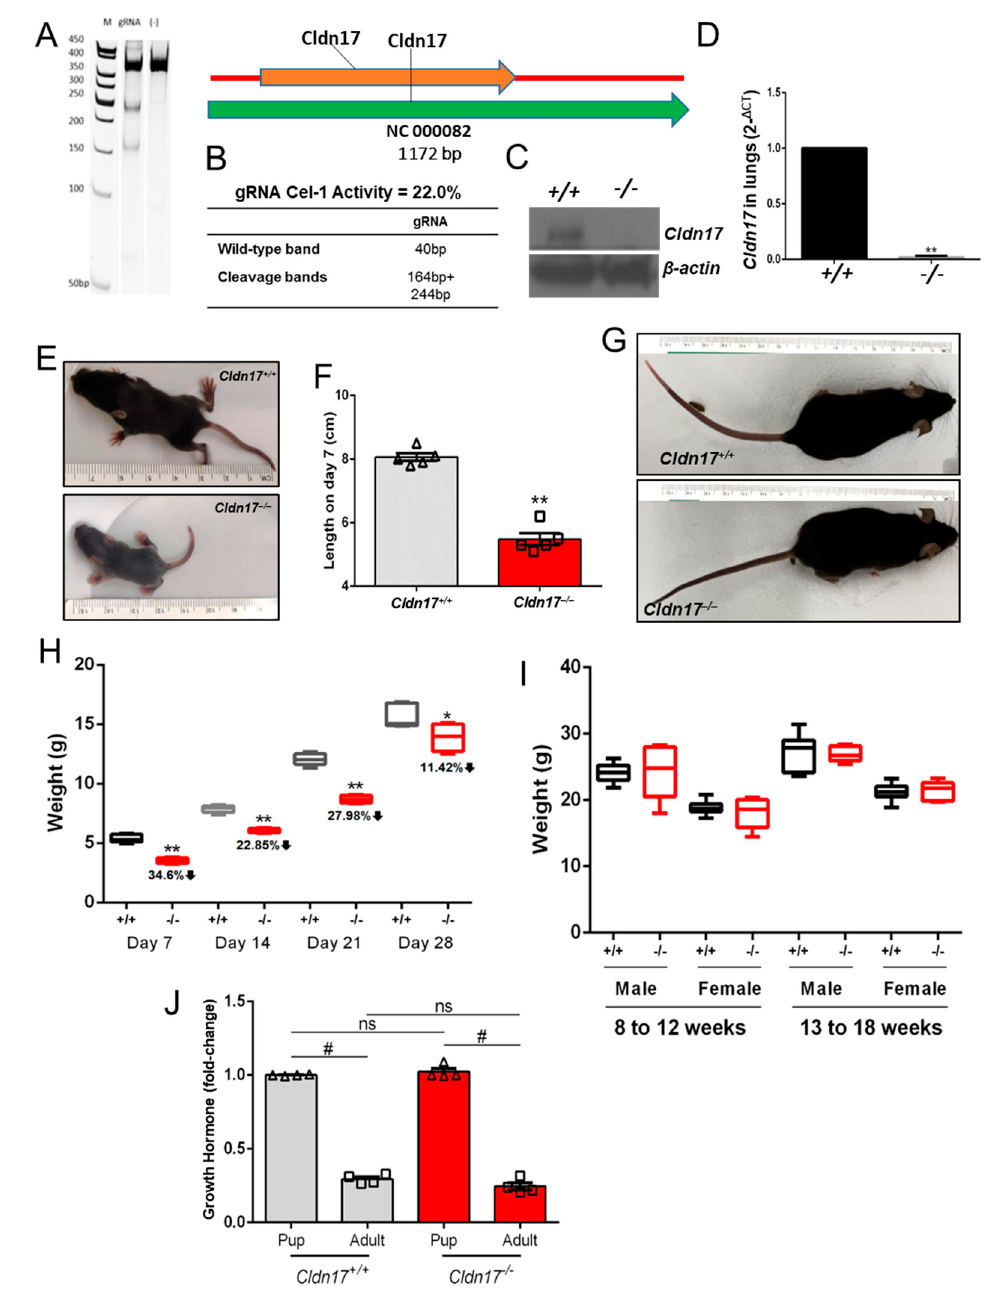
Figure 1. Cldn17 deficiency delays growth in young mice. ( A , B ) Cel-1 assay validation gel representing Cldn17 gene knockout and gRNA base-pair details for WT and cleavage bands. ( C ) Western blot images validating gene loss at the protein level in kidneys. ( D ) Bar graph showing mRNA level in lungs ( n = 5). ( E ) Images (dorsal view) of WT and Cldn17 –/– mice on day 7. ( F ) Lengths of WT and Cldn17 –/– mice on day 7 (n = 5). ( G ) Images (dorsal view) of WT and Cldn17 –/– mice at week 14. ( H ) Growth hormone levels in pups and adult mice from WT and Cldn17 –/– liver samples. ( I ) Weights of mice that were recorded at weeks 1 to 4 (n = 5) and ( J ) weeks 8 to 18 (n = 5–12). Data presented as mean ± s.e.m.; +/+, WT; –/–, Cldn17 knockout; gRNA, guide RNA; bp, base-pair; g, gram; cm, centimeter; ns, not significant; * p < 0.05; ** p < 0.0001; # p < 0.01.